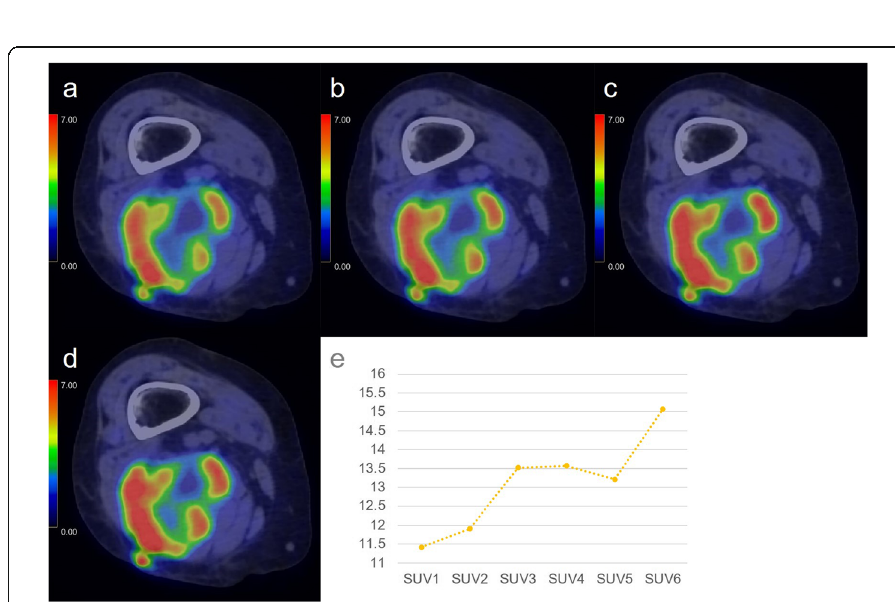
Fig. 5 An 85-year-old woman with diffuse large B cell lymphoma in the right thigh. Dynamic positron-emission tomography/computed tomography (PET/CT) ( a – d ) images are shown. In all dynamic phases ( a – d ), methionine accumulation in the soft tissue tumour is inhomogeneous, and intense accumulation is identifiable in the peripheral regions from the dynamic first phase (SUVmax: dynamic first phase ( a ), 11.42; dynamic second phase ( b ), 11.91; dynamic third phase, 13.52; dynamic fourth phase ( c ), 13.57; dynamic fifth phase, 13.21; dynamic sixth phase ( d ), 15.07). The accumulation gradually becomes more intense in most parts of the tumour during the dynamic phases ( a – d ). The time-SUVmax curve ( e ) shows a high level in SUVmax at the dynamic first phase (5 – 15min after injection) and a gradual increase during the dynamic